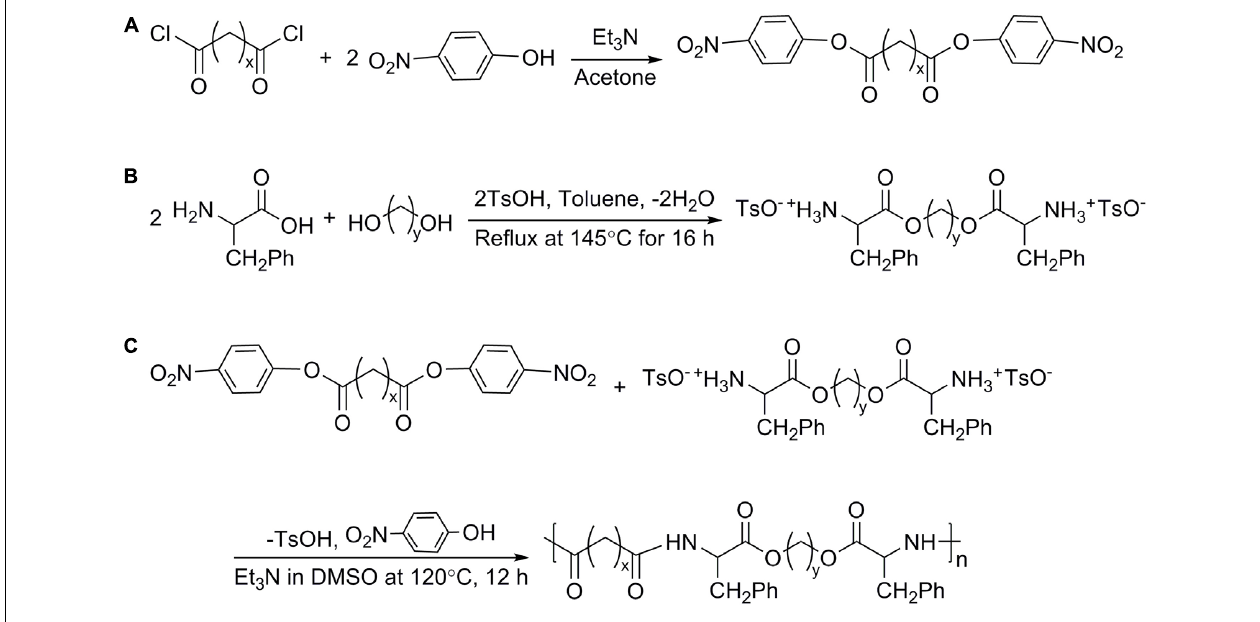
FIGURE 2 | Synthetic routes of Phe-PEA polymers. TABLE 1 | Phe-PEA polymers and their corresponding NPs. Monomer